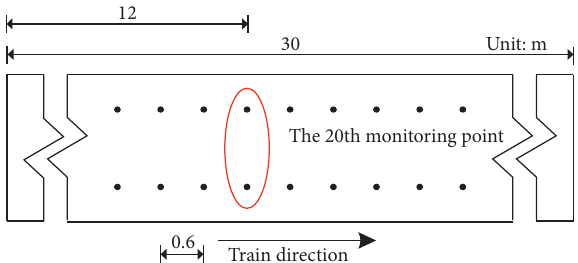
Figure 11: Position diagram of monitoring